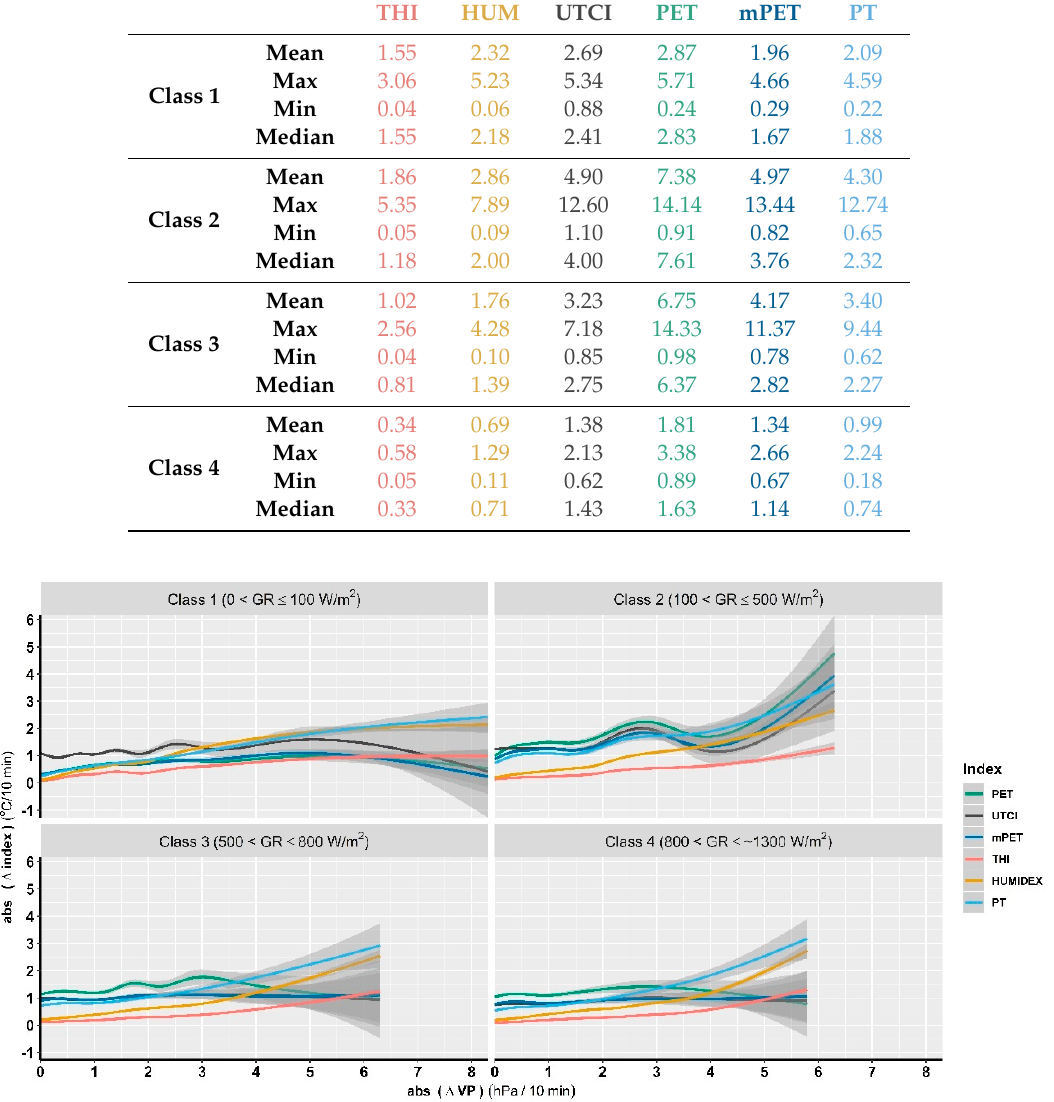
Figure 11. The sensitivity of the indices to the vapour pressure (VP) change rate under different global radiation (GR) conditions.